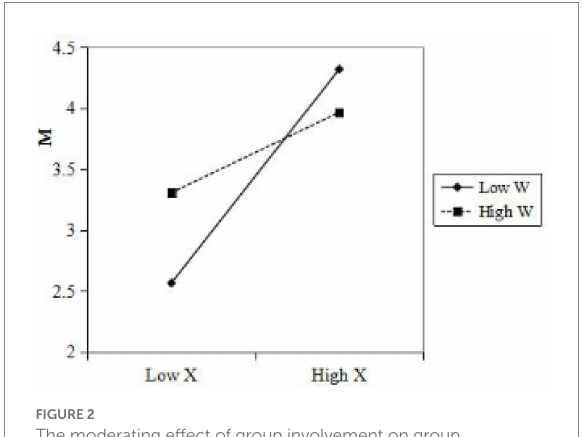
FIGURE 2 The moderating effect of group involvement on group communication and product image perception.